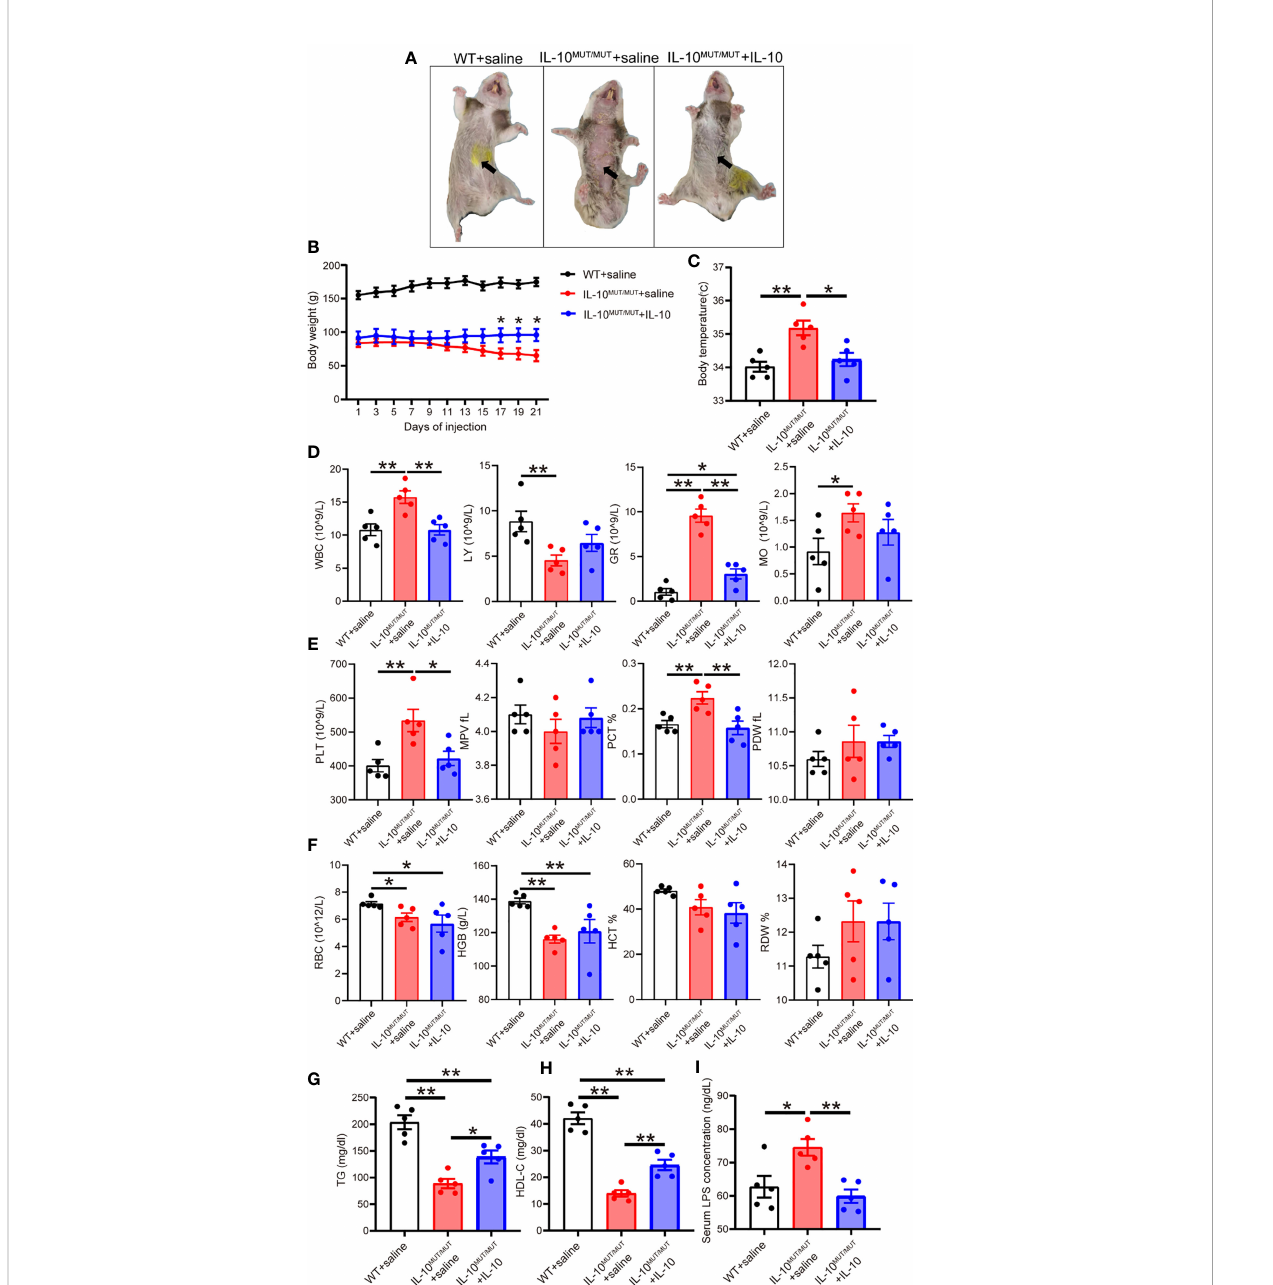
FIGURE 8 Short-term injection of rhIL-10 corrected the abnormal phenotypes of IL-10 MUT/MUT hamsters on chow diet. (A) Representative images of WT hamsters injected with saline (WT + saline), IL-10 MUT/MUT hamsters injected with saline (IL-10 MUT/MUT + saline) and IL-10 MUT/MUT hamsters intraperitoneally injected with rhIL-10 for 21 days (1 m g/kg/day, IL-10 MUT/MUT + IL-10). (B) Body weight curve of WT + saline, IL-10 MUT/MUT + saline and IL-10 MUT/MUT + IL-10 hamsters (n=5/group). (C) Body temperature of WT + saline, IL-10 MUT/MUT + saline and IL-10 MUT/MUT + IL-10 hamsters on day 21 after injection (n=5/group). (D, E and F) The blood biochemical characteristics of WT + saline, IL-10 MUT/MUT + saline and IL- 10 MUT/MUT + IL-10 hamsters on day 21 after rhIL-10 injection (n=5/group). (G, H) Plasma TG (G) and HDL-C (H) from WT + saline, IL-10 MUT/MUT + saline and IL-10 MUT/MUT + IL-10 hamsters on day 21 after injection (n=5/group). (I) Plasma LPS level from WT + saline, IL-10 MUT/MUT + saline and IL-10 MUT/MUT + IL-10 hamsters on day 21 after injection (n=5/group). All date were expressed as means ± SEM, *p<0.05;